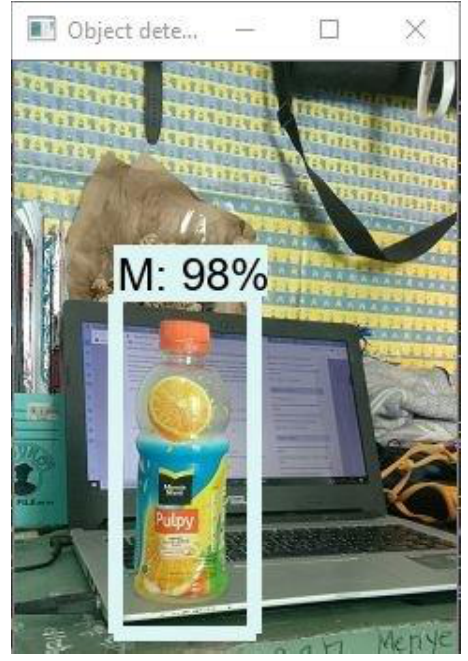
Figure 6. Result Classification with CNN